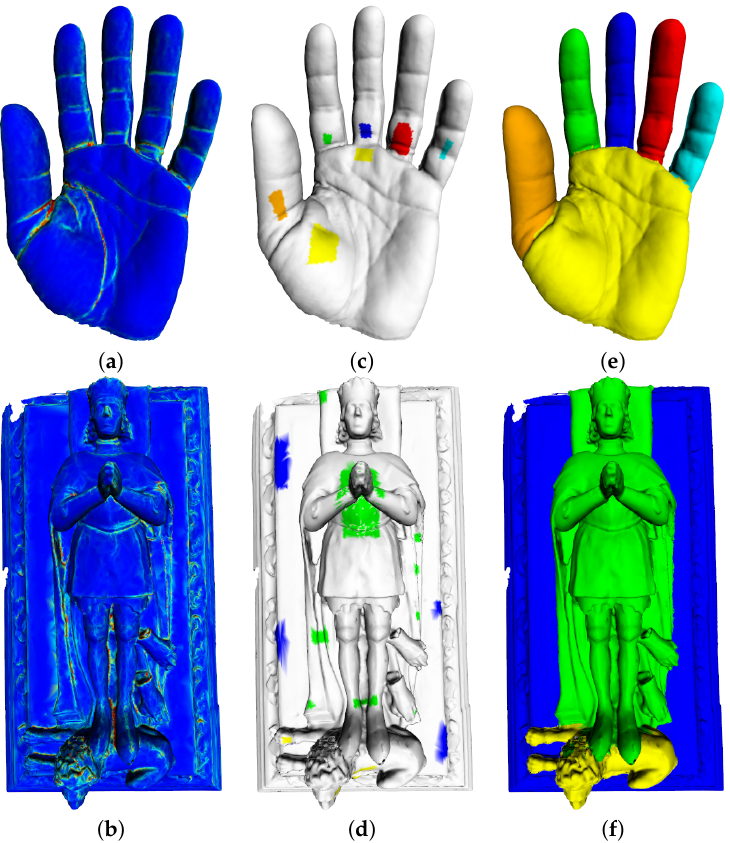
Figure 11. Segmentation of 3D meshes based on the geometric principal curvatures by solving the Eikonal equation with P ( u ) = 1 (see Section 4.2.1). ( a , b ) show the square of major principal curvature (blue color for low values, red for high values); ( c , d ) show the initial labels on the 3D mesh; ( e , f ) show the results of the geometric